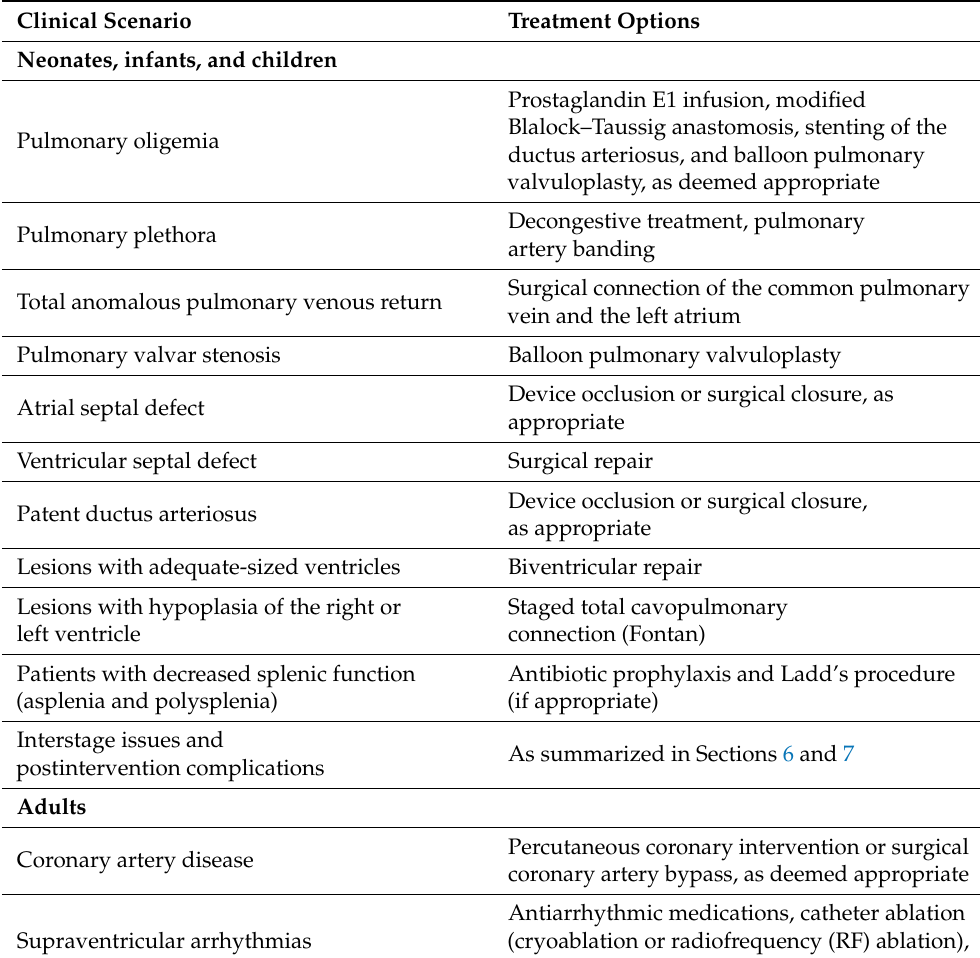
Table 1. Therapy of cardiac